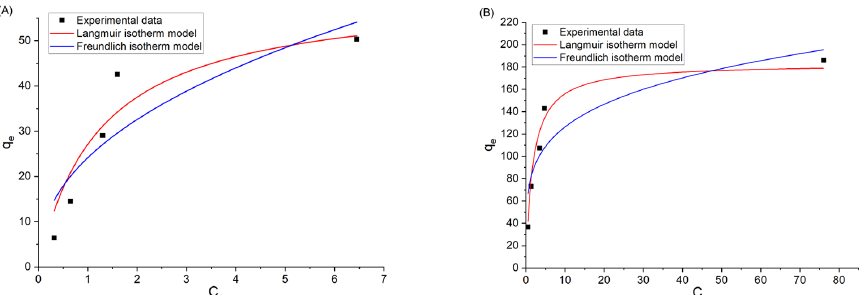
Figure 7. Adsorption isotherms of Fl and CV at 298 K: ( A ) Langmuir adsorption isotherm, and ( B ) Freundlich adsorption isotherm. Table 2. Langmuir parameters for the adsorption process at 298 K.